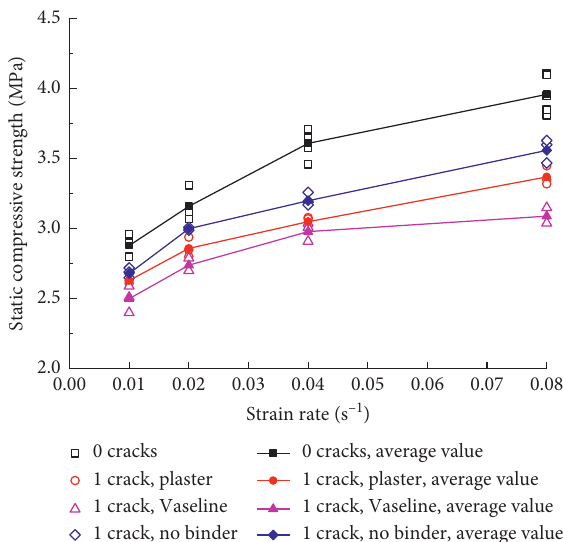
Figure 4: Static strength with three kinds of binder